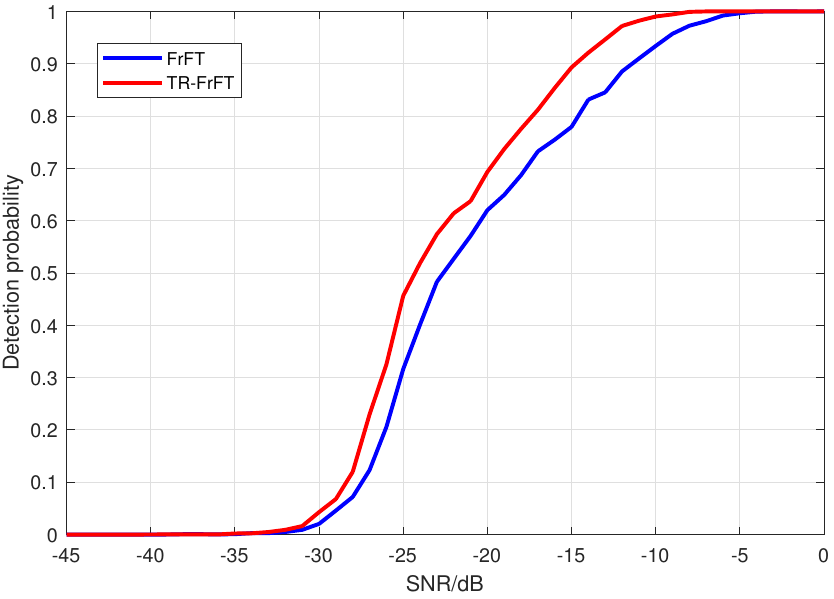
Figure 14. Detection probability vs. SNR for FrFT and TR-FrFT with the simulated data. The false alarm rate is P F = 0.1. The Doppler frequency shift is 0